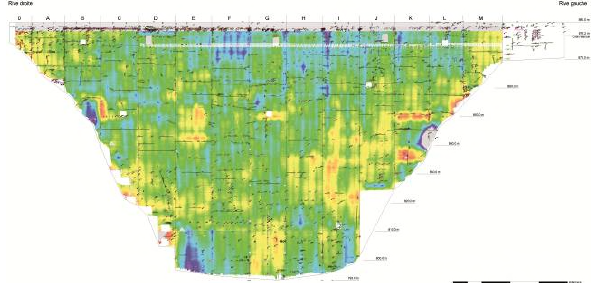
Figure 10. Map overlaying deflection/defects and magnifying